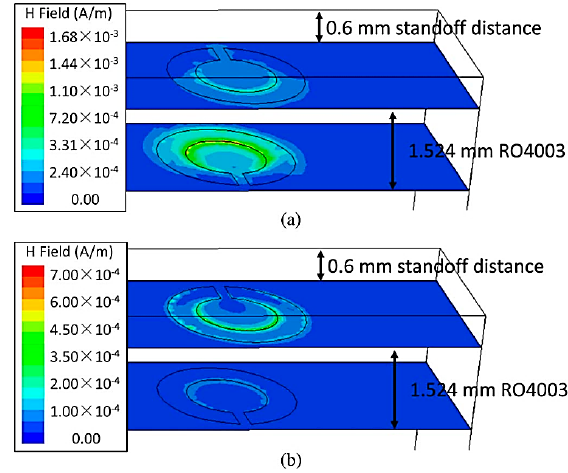
Figure 20. Magnetic fi eld distributions at the resonance frequencies of the SRR cells: ( a ) at 14.53 GHz and ( b ) at 16.24 GHz (from [40]; copyright © IEEE 2014; reproduced with permission).